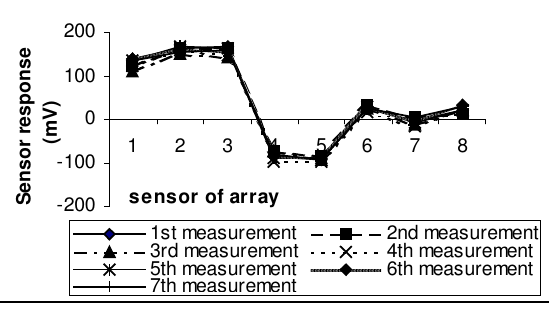
Fig. 3. Response of the disposable sensor strips for seven measurements of immature